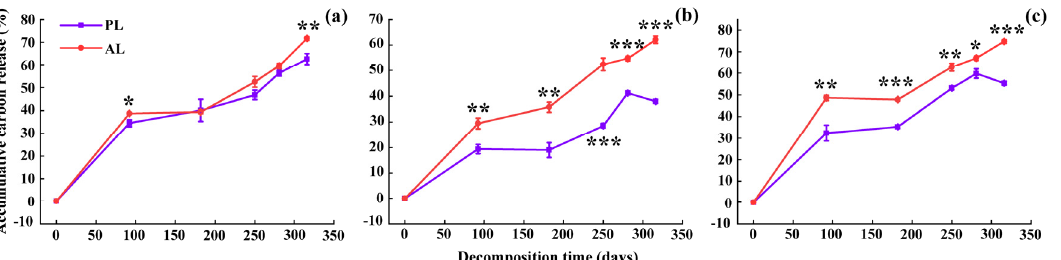
Figure 5. The accumulative carbon release rates (%) of goldenrain tree ( a ), camphor tree ( b ), and weeping willow tree ( c ) foliar litter in the urban forest. PL and AL indicate physiological and abnormal litter, respectively. * p < 0.05, ** p < 0.01, *** p < 0.001.